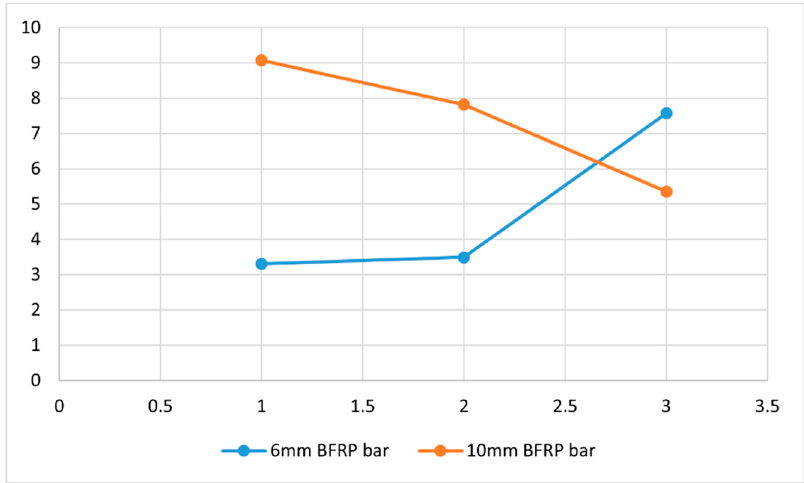
Figure 16 . Bond stress vs. embedment length to bar diameter (L/d b ). Figure 16. Bond stress vs. embedment length to bar diameter (L/d